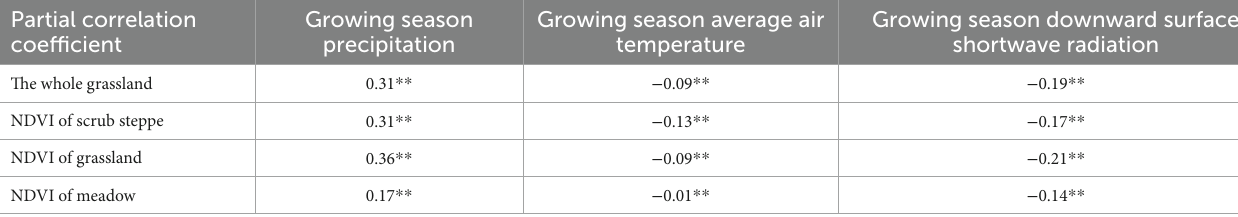
TABLE 4 Partial correlation of NDVI and meteorological factors in the growing season of Mongolian Plateau. Partial correlation coefficient